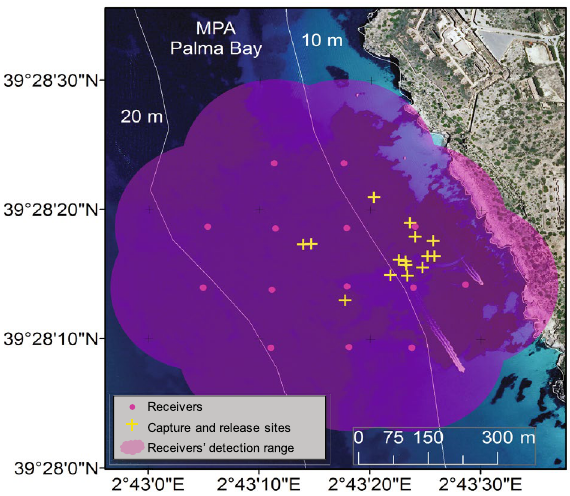
Figure 4. Map of the study area showing the acoustic tracking experimental setup. The map shows the distribution of the acoustic receivers (pink dots) deployed within the no-take Marine Protected Area (MPA) of Palma Bay (Mallorca, Spain), as well as the expected detection range of the receivers (shaded pink). The map also shows the habitat characteristics of the study area comprising a seagrass meadow of Posidonia oceanica (dark blue) with patches of sand (light blue). Isobaths show site depth in meters. Yellow crosses indicate the locations where the individuals were caught and released after tagging. Note in the map the two